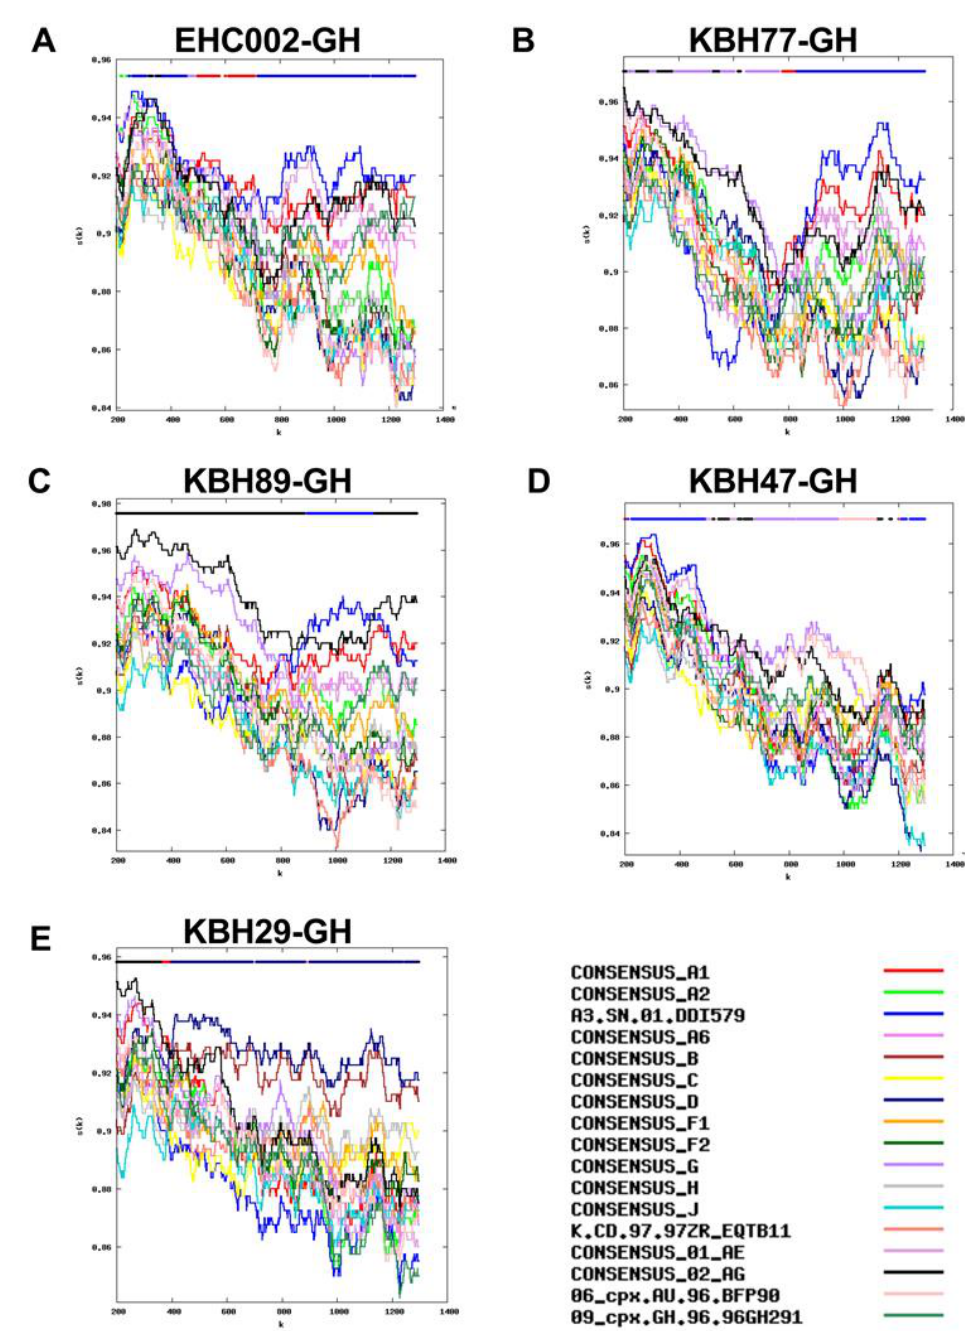
Figure 3. Protease-RT sequences where subtype classification was not possible at the predefined confidence threshold. The y-axis denotes the % similarity between the participant sequence to each of 17 reference sequences (each in a different color) over a sliding window of 400 bases (shown on X axis). The bars at the top of each plot indicate the best matching reference sequence over a given sequence region (lower bar) and whether this match meets the 95% confidence threshold (upper bar). The RIP plots however show the recombinant composition as follows: Panel ( A ) Mosaic of subtypes A3 and A1. ( B ) Mosaic of G and/or CRF02_AG at the 5’ end, with A3 at the 3’ end. Panel ( C ) Likely recombinant of CRF02_AG and A3. Panel ( D ) Mosaic including A-like, G-like, CRF02_AG-like and/or 06_cpx-like sequences. Panel ( E ) Likely recombinant of CRF02_AG and subtype D. The sequences are presented in the same order as they appear in the phylogeny (in Figure 4), from top to bottom.